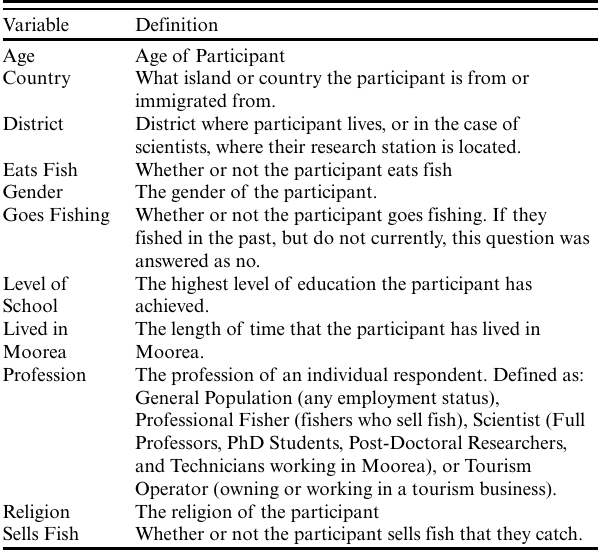
Table 1 . Social attribute information collected for each survey